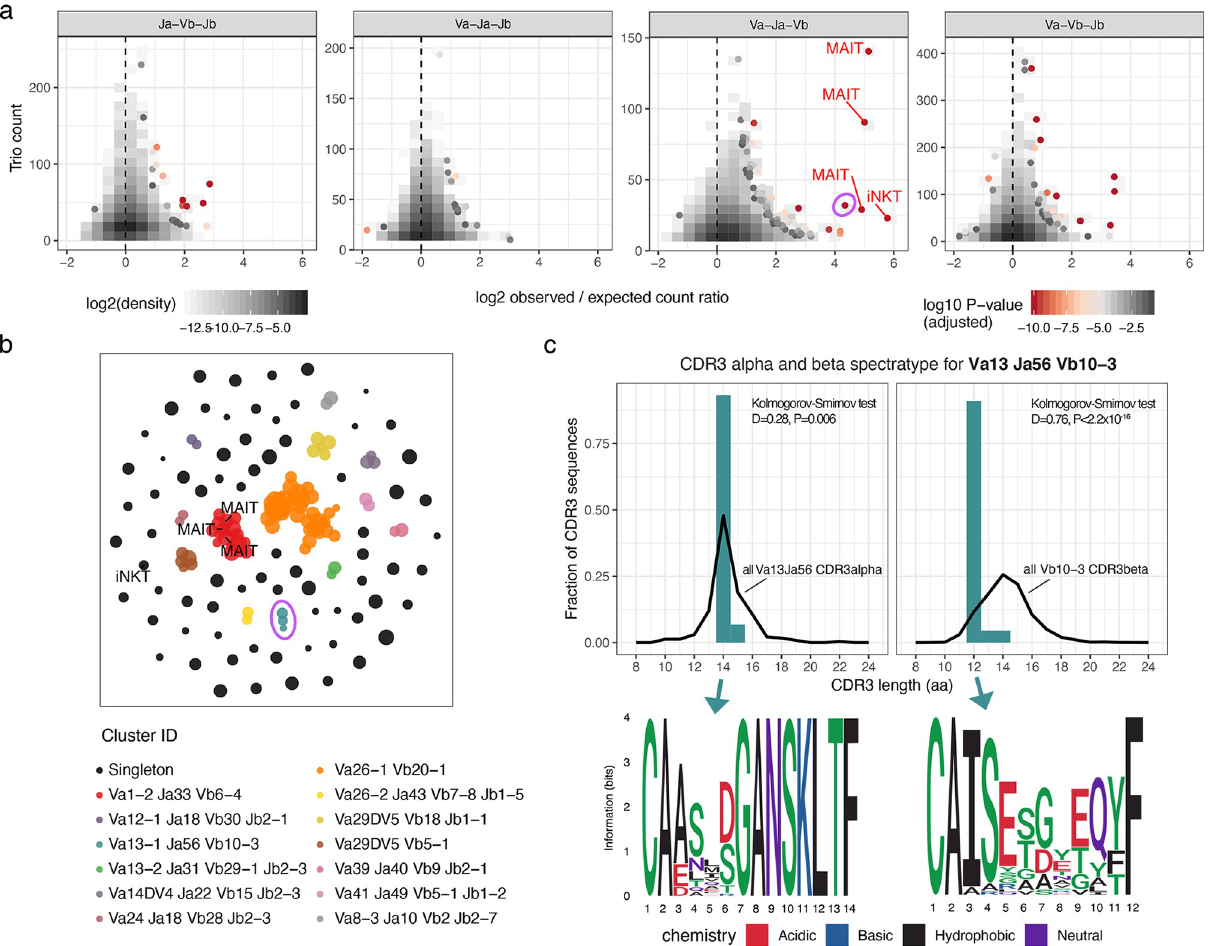
Fig 8. Exploring invariant TCR using enrichment analysis of V α J α V β J β gene combinations. a. Scatterplot showing enrichment of certain TCR gene trios (unique combinations of three of four TCR germline genes, either J α V β J β ,V α V β J β ,V α J α J β or V α J α V β )in the PairSEQ dataset. Logarithm of the ratio of the observed and expected counts for all possible gene trios is plotted against their observed count. Expected count is calculated under the assumption of random αβ pairing as (count of α part alone) x (count of β part) / (total number of reads). Points are colored by the P-value of the hypergeometric enrichment test for the co-occurrence of α and β parts of the gene trio (adjusted for multiple comparisons using Holm method). Canonical MAIT (TRAV1-2, TRAJ12/20/33, TRBV6-4) and iNKT (TRAV10, TRAJ18, TRBV25-1) variants are highlighted with corresponding labels. Only gene trios supported by at least 10 reads are shown. Pink circle highlights the Va13 Ja56 Vb10-3 population. b. Grouping of selected TCR gene trios (having adjusted P < 0.05 for enrichment test and represented by at least 10 reads) according to overlap between their V α J α V β J β gene sets. The plot shows the layout of the resulting graph of gene trios (nodes), having edges connecting pairs of nodes with exactly matching gene sets (missing genes, e.g. V α in J α V β J β ,are considered as wildcards). Nodes of the graph are represented by points and are colored according to the connected component (cluster) of the network they were assigned to. Cluster ID is a combination of most frequent gene names in co-clustered trios. c. CDR3 spectratyping and motifs for the Va13 Ja56 Vb10-3 population. Top plots show distribution of CDR3 alpha (left) and beta (right) chains of the population compared to all PairSEQ TCRs rearranged with corresponding alpha or beta segments, note that only a single dominant length is present for both alpha and beta. Bottom plots show sequence logos of corresponding CDR3 lengths in the